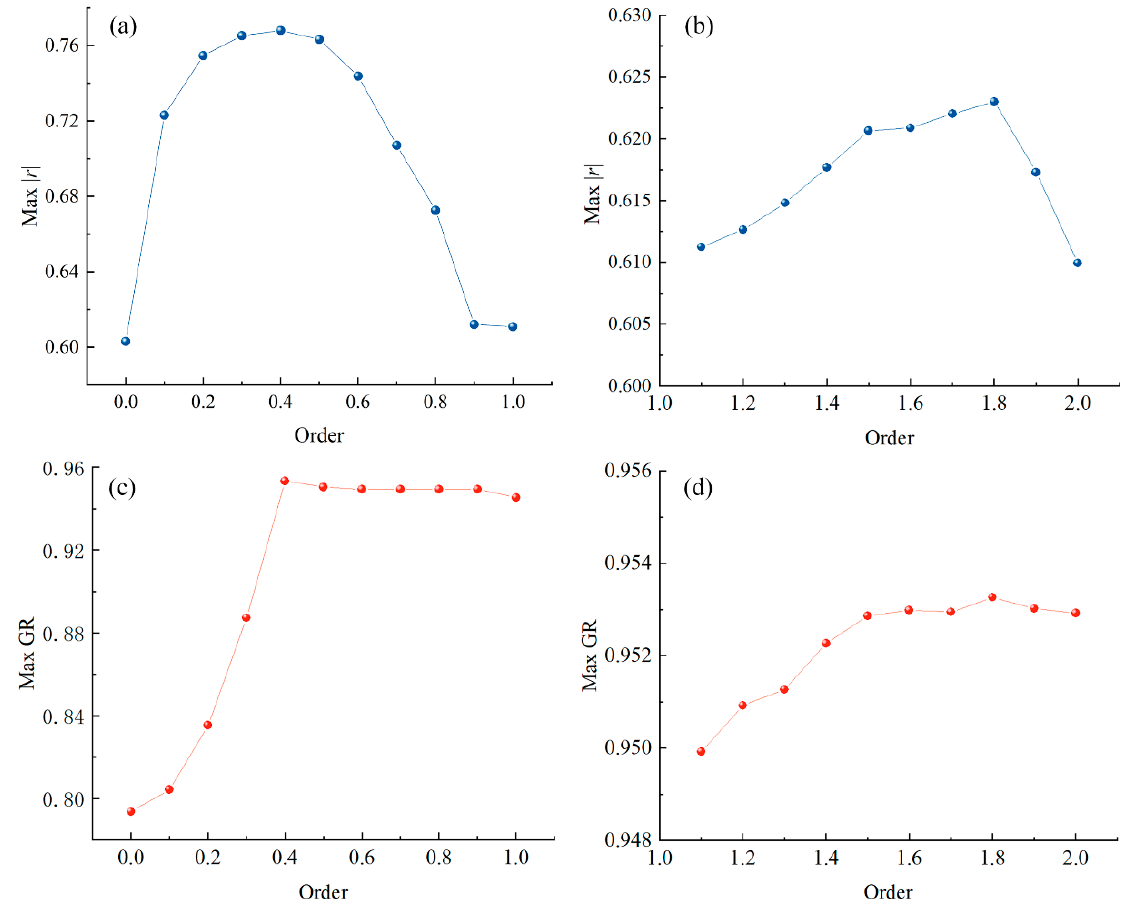
Figure 6. Max | r | and max GR at 21 derivative orders (0 to 2, with an increment of 0.1 per step): ( a ) max | r | for the orders of 0–1; ( b ) max | r | for the orders of 1.1–2; ( c ) max GR for the orders of 0–1; ( d ) max GR for the orders of 1.1–2.